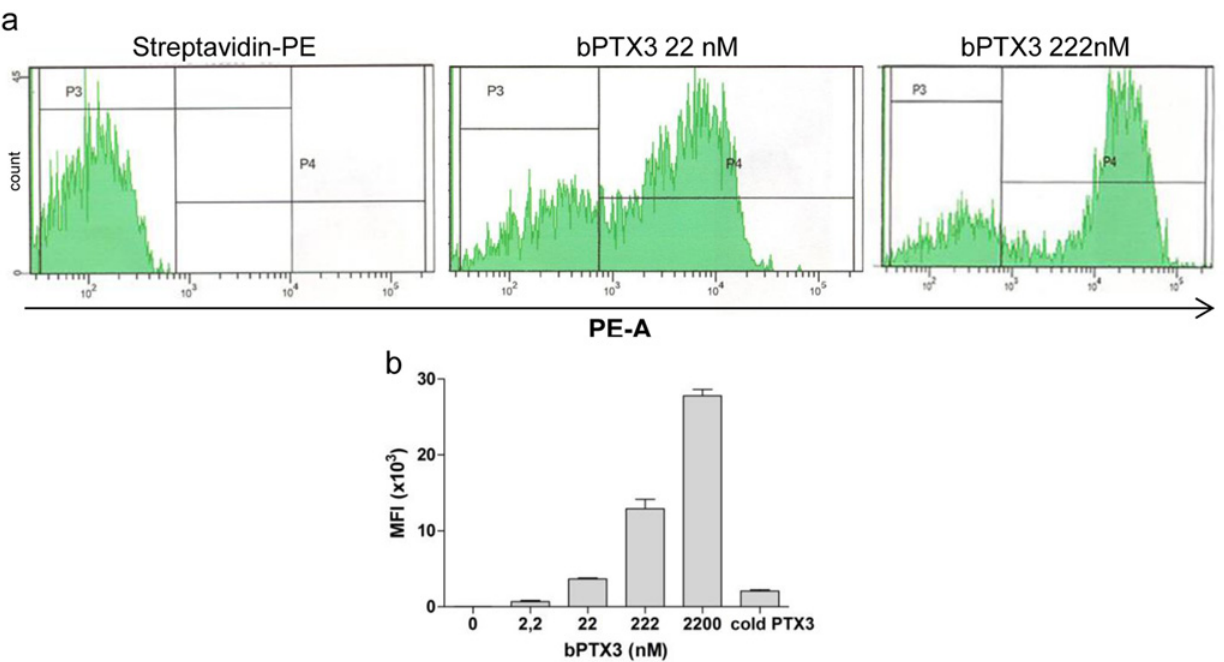
Fig 1. FACS analysis of PTX3 binding to Neisseria meningitidis . Live bacteria were incubated with different doses of human bPTX3 for 1h at room temperature. Results were assessed by flow cytometry. a) Histograms from one out of three experiments performed, showing the negative control (Streptavidin-PE) and two doses of bPTX3 (22 nM and 222 nM); b) Dose response of human bPTX3 (2.2 – 2200 nM) binding to Nm. Results are MFI ± SD from three independent experiments. Preincubation with cold human PTX3 (1.1 μ M — 10 min at room temperature) before addition of bPTX3 (222 nM) results in a 86.5% reduction of